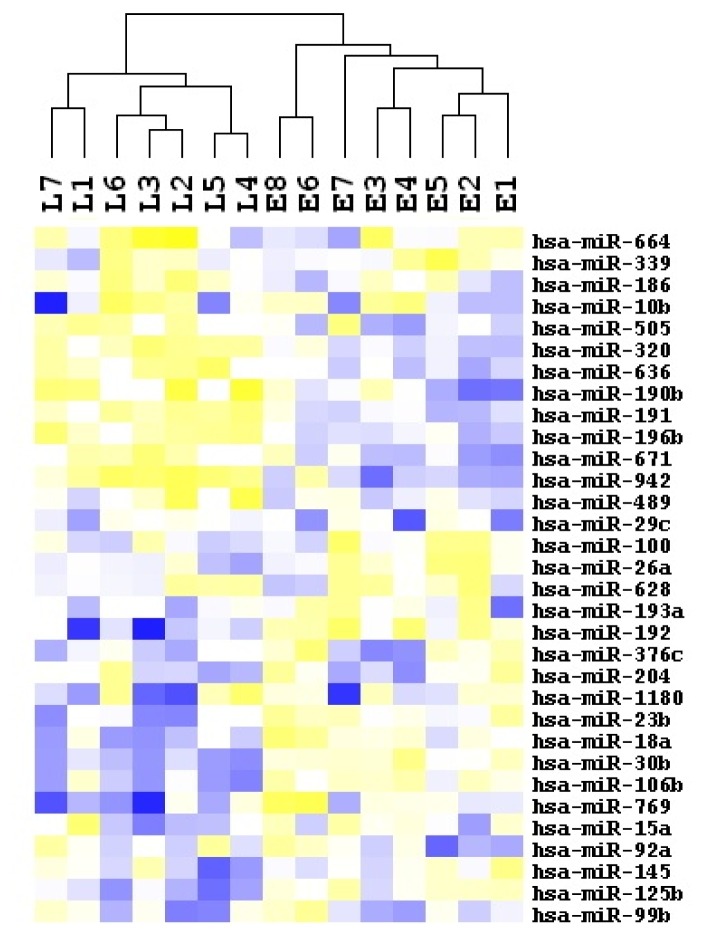
Hierarchical clustering of 32 miRNAs whose expressions were significantly altered in late recurrent HCC samples in contrast with early recurrent HCC samples.